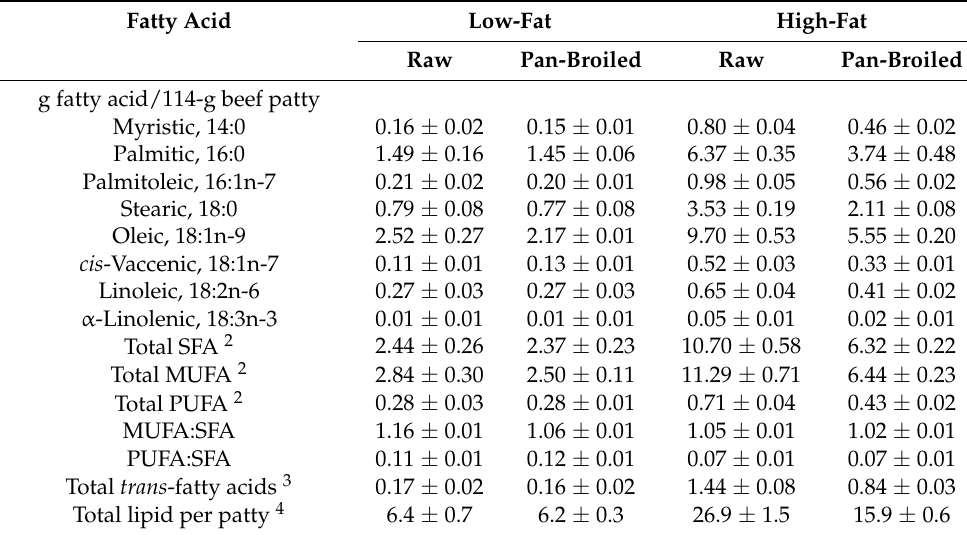
Table 1. Fatty acid composition and lipid content of raw and pan-broiled low-fat and high-fat ground beef patties 1